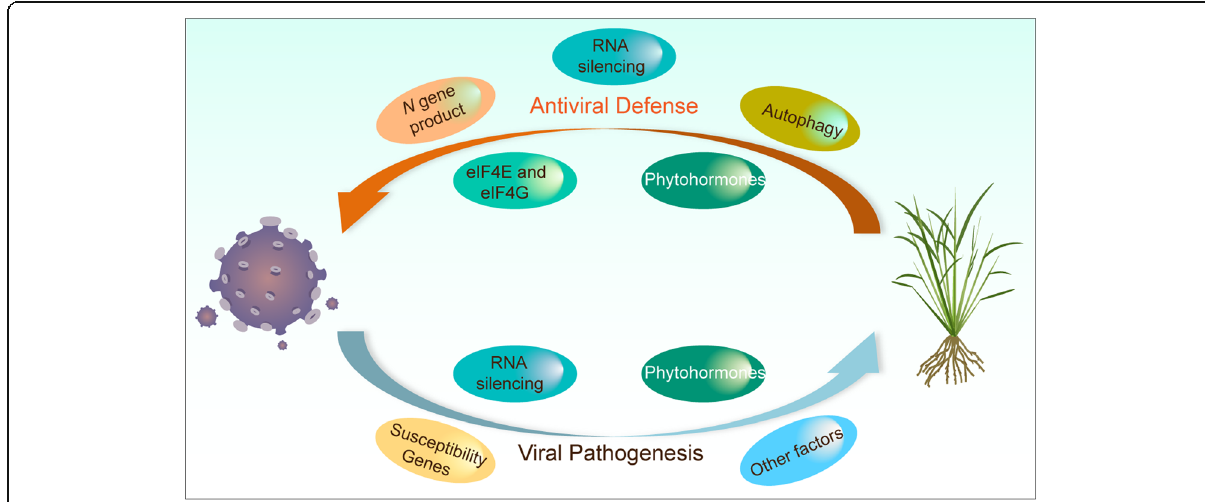
Fig. 1 Schematic diagram showing the arms race between rice host and rice viruses. N gene mediated pathway, RNA silencing pathway, phytohormone pathway, recessive gene resistance and autophagy mediated pathway play important roles during rice-virus